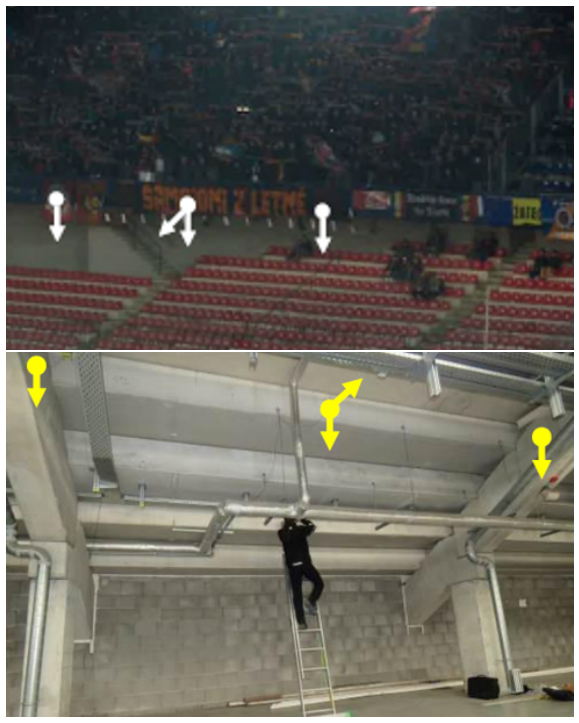
Figure 5. Sensors placement: a) Letna Stadium [1], b) Eden stadium [4].